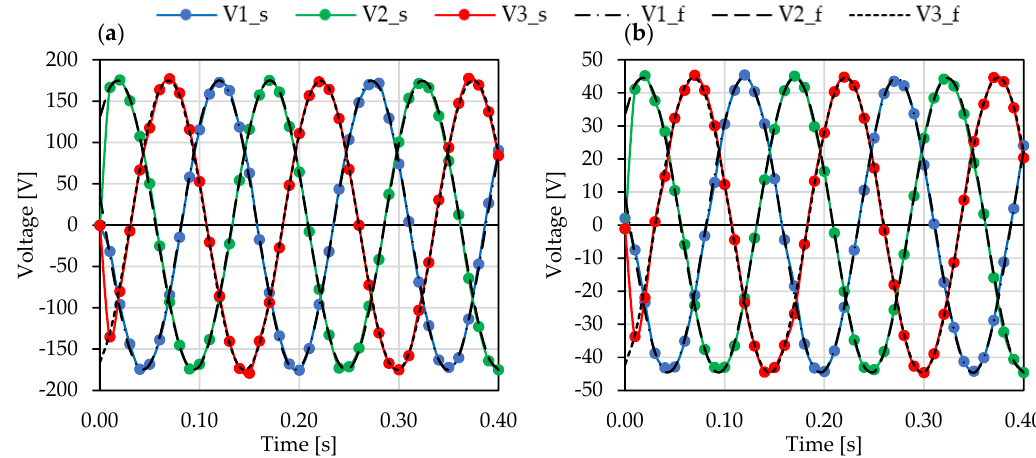
Figure 14. Comparison of no-load voltages obtained, not connecting the star center of the generator to load. ( a ) iron-core stator, ( b ) air-core stator.